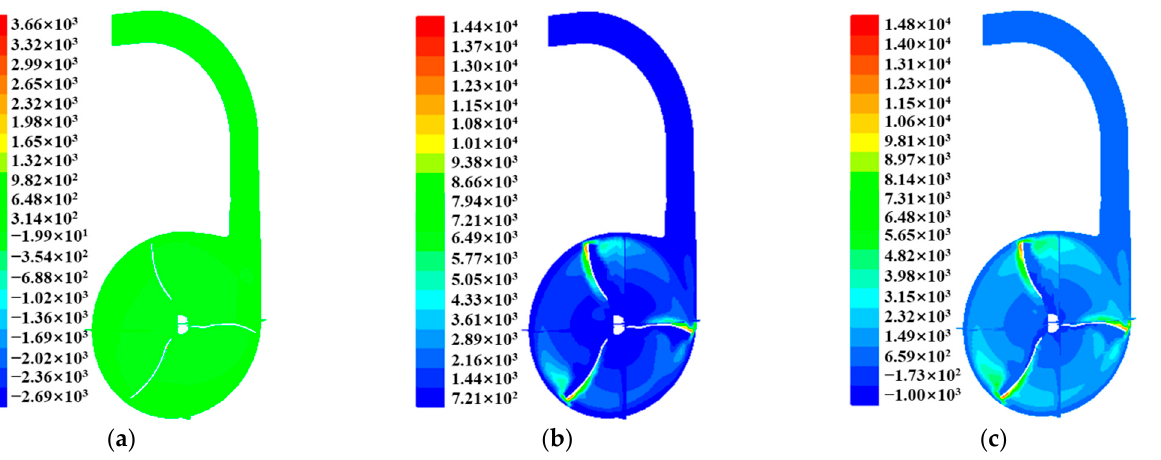
Figure 10. Pressure cloud diagram in the device. ( a ) The mixed static pressure cloud of the gas–solid two-phase. ( b ) The dynamic pressure cloud of crushed straw material phase. ( c ) The total pressure cloud of the crushed straw material phase.